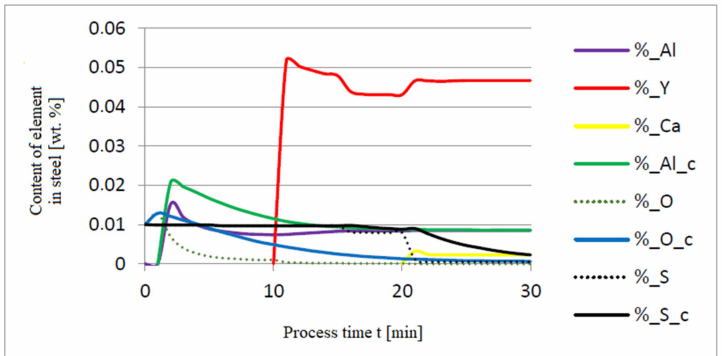
Figure 5. Change in the content of an element in liquid steel (wt.%) depending on the process time t (min).